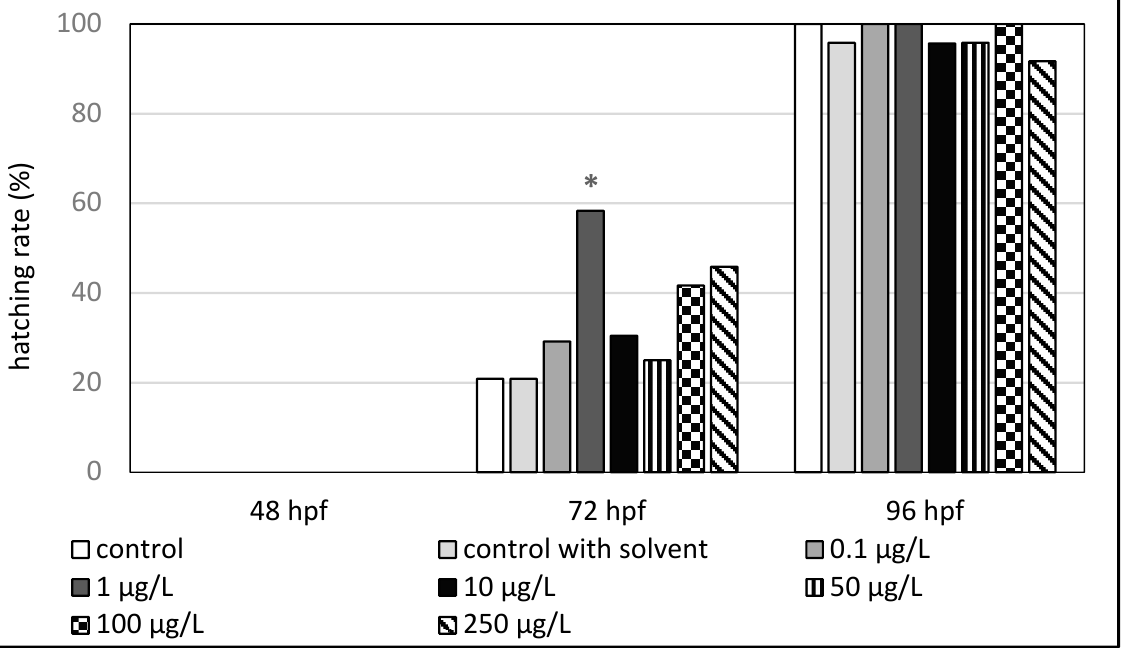
Figure 2. Hatching rate (%) of zebrafish embryos exposed to octocrylene (hpf—hours post fertilization). The asterisk indicates a significant difference (* p < 0.05) between the control and experimental groups at the same time of